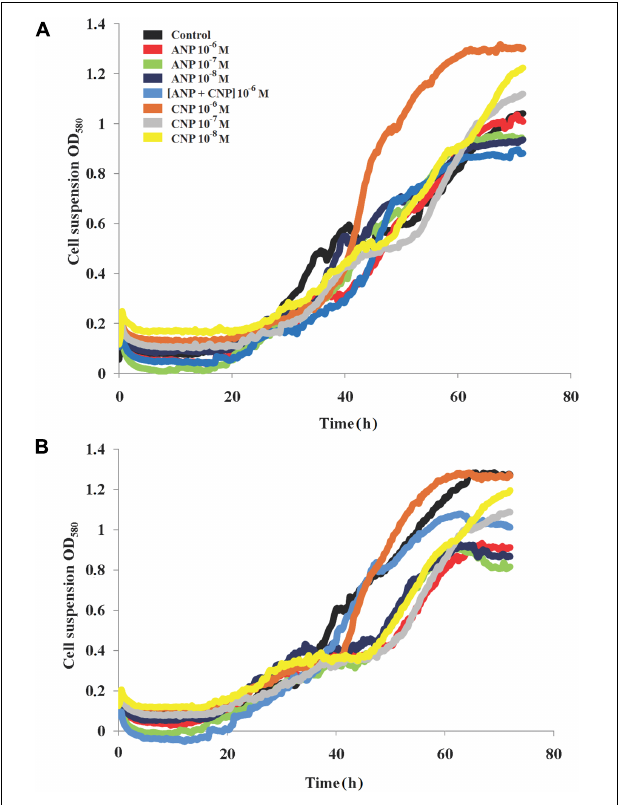
FIGURE 2 | Growth dynamics of C. acnes RT4 and RT5 monospecies cultures at 37 ◦ C in the presence of ANP and CNP. (A) C. acnes RT4 and (B) C. acnes